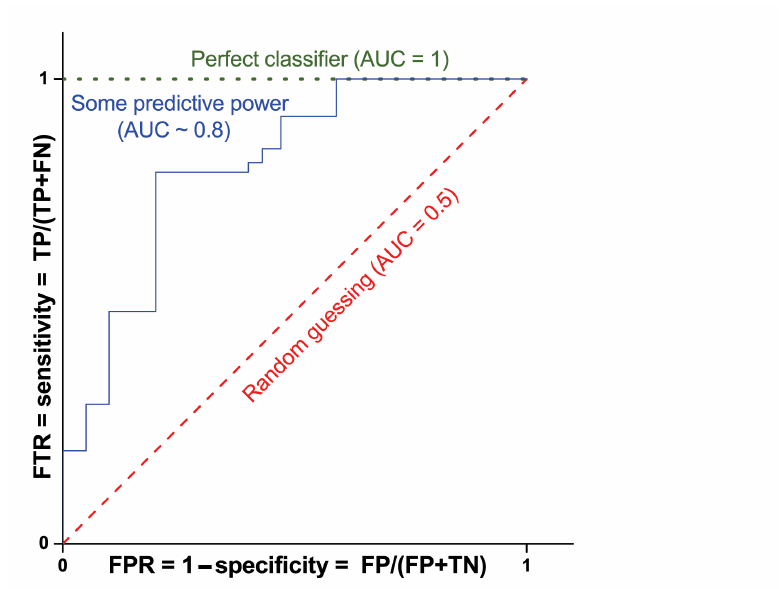
Figure 6. ROC curves and corresponding AUC values for three classifiers: no predicting power (red dashed line with AUC = 0.5), perfect classifier (green dotted line with AUC = 1) and some predictive power (blue solid line with AUC ∼ 0.8).